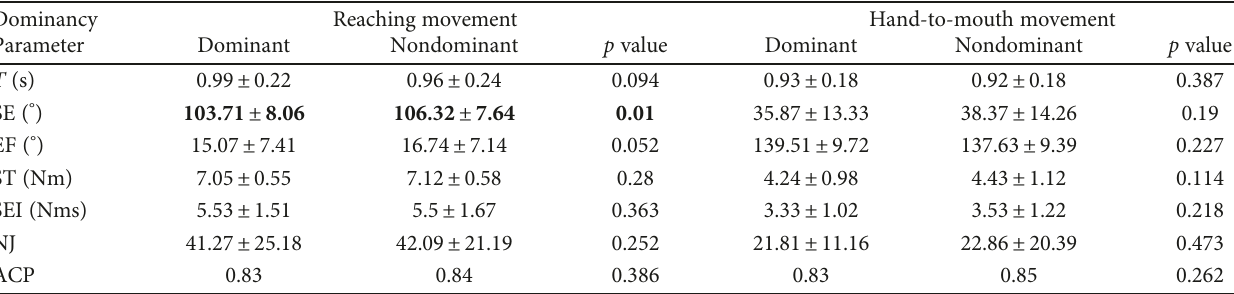
Table 2: Dominancy subsets.